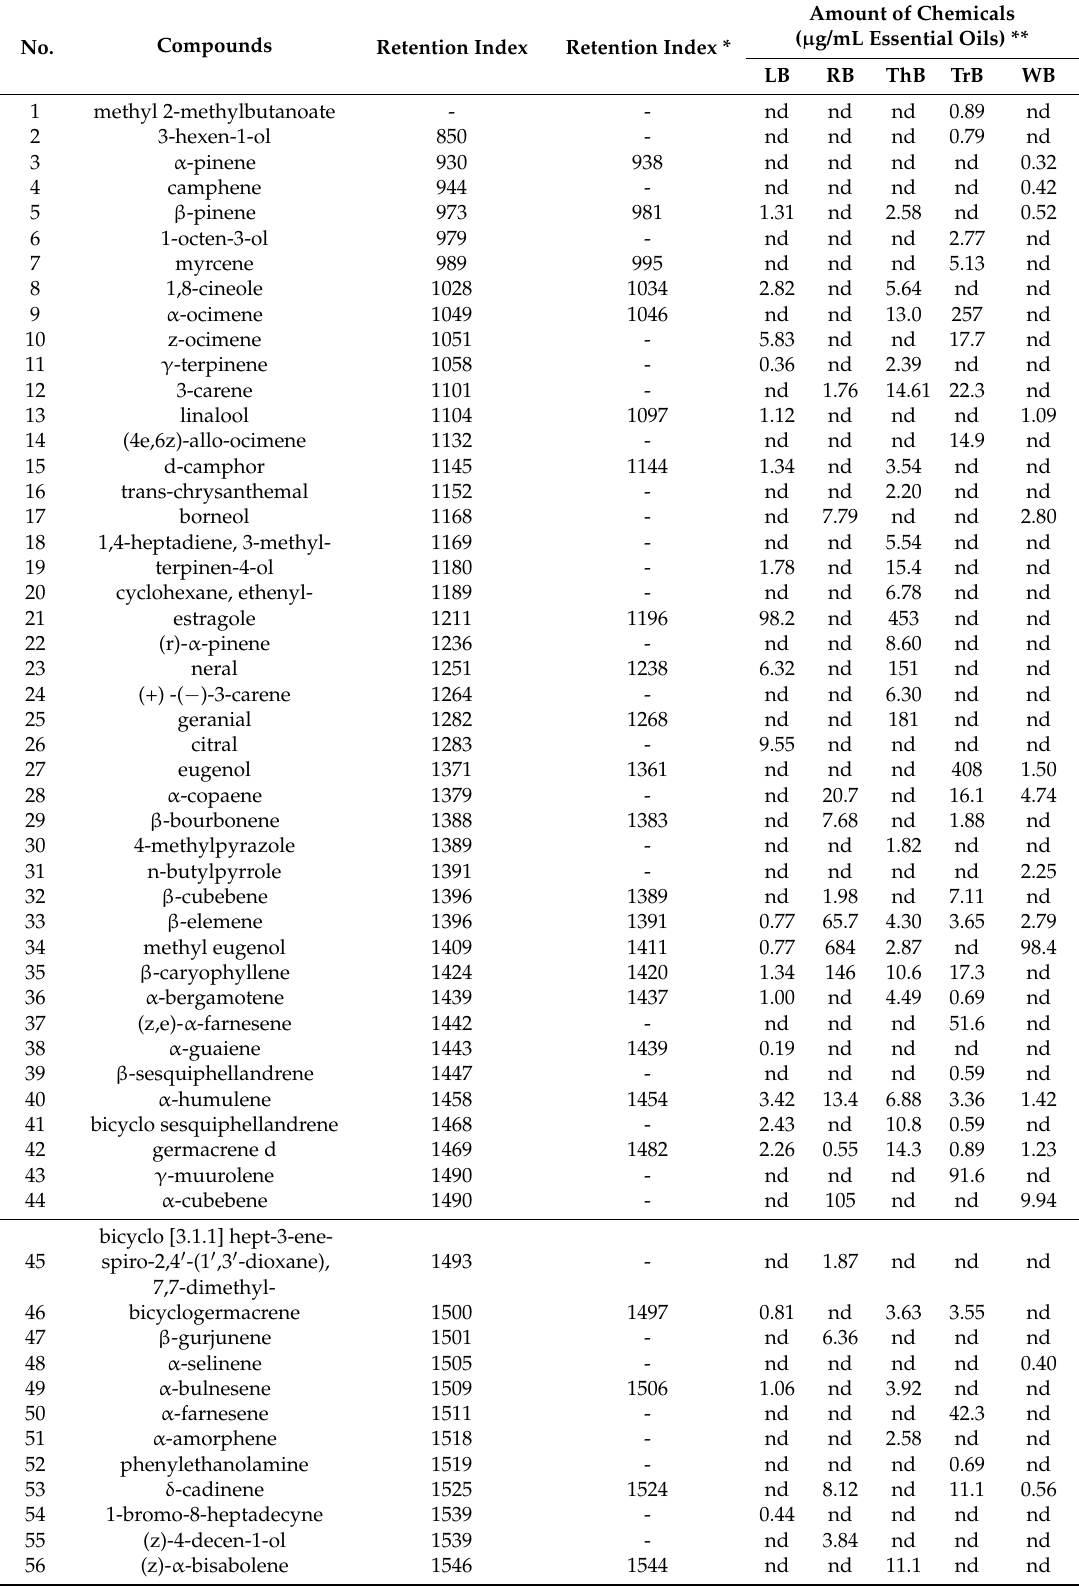
Table 3. Chemical compositions of the essential oils from five Ocimum spp.